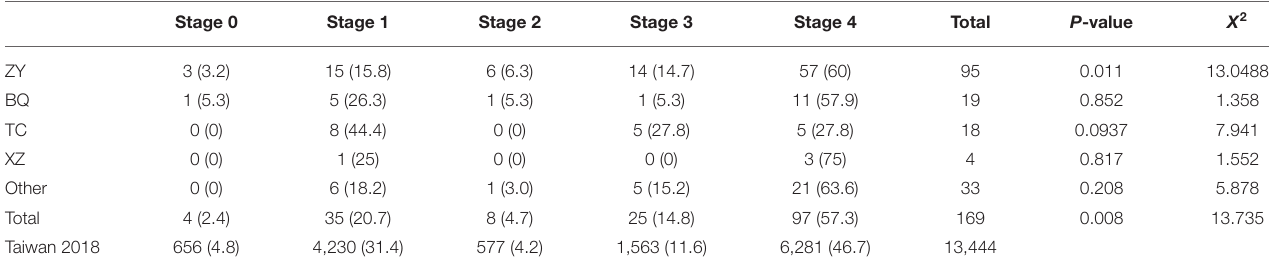
TABLE 3 | The number and percentage of lung cancer stage.